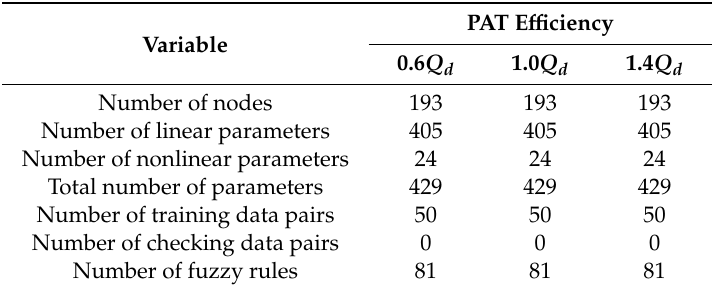
Figure 10. ANFIS model structure. ANFIS information used for solving the influence of the design variables over the objective